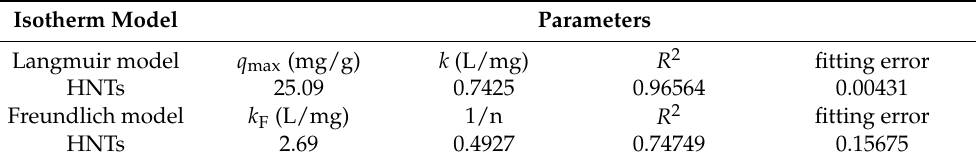
Figure 3. The linearized Langmuir ( a ) and Freundlich isotherm ( b ) for adsorption CIP on HNTs. Table 2. Parameters for the Langmuir and Freundlich models. HNTs—halloysite nanotubes. Isotherm